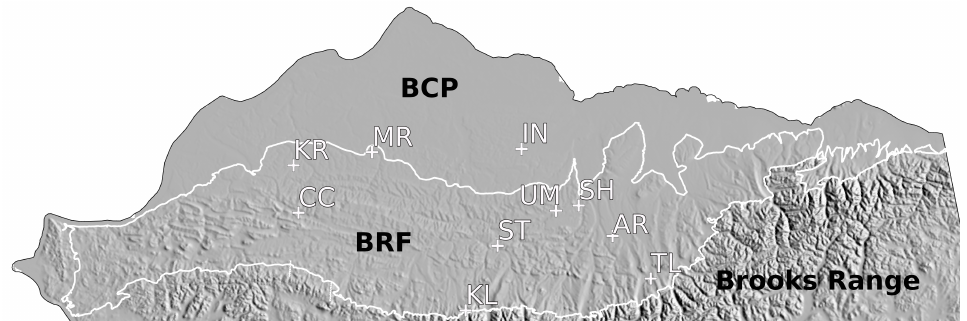
Figure 1. Map of the Arctic Slope and the Brooks Range Foothills ecoregion (BRF) study area (white outline) [18]. BCP = Beaufort Coastal Plain ecoregion. White abbreviations are places mentioned in the text: KR, MR, ST, and SH are the Ketik River, Meade River, Starfish Bluff, and Shivugak Bluff prehistoric burns, respectively; CC = Carbon Creek drainage, AR = Anaktuvuk River Fire, UM = Umiat, IN = Inigok, TL = Toolik